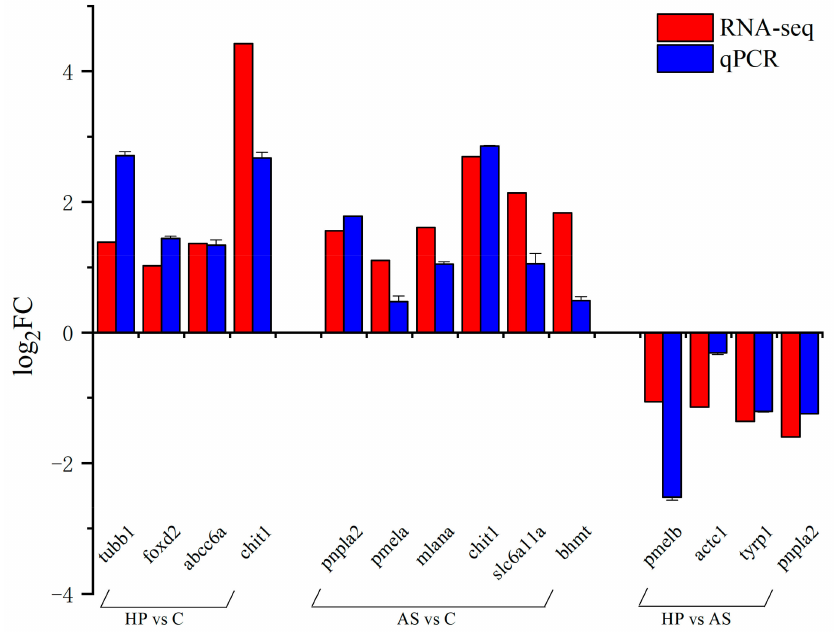
Figure 4. Comparison of the expression levels of DEGs by qPCR and RNA-seq. The x-axis is the gene name, and the y-axis indicates the log 2 FC of genes. Data are presented as mean ± SD. The letter C is control, AS is synthetic astaxanthin, HP is natural astaxanthin, qPCR is quantitative real-time